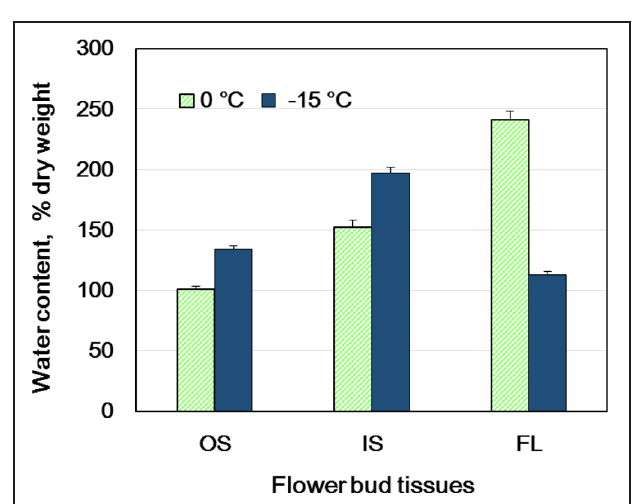
FIGURE 2 | Changes in the water content of flower bud tissues of wintering R. japonicum (collected in early December) during slow cooling (5 ◦ C/day) to − 15 ◦ C and subsequent storage at − 15 ◦ C for 3 days. OS, outer scales; IS, inner scales; FL, florets. The water content is expressed on a dry weight basis (mean ± SE, n = 4).